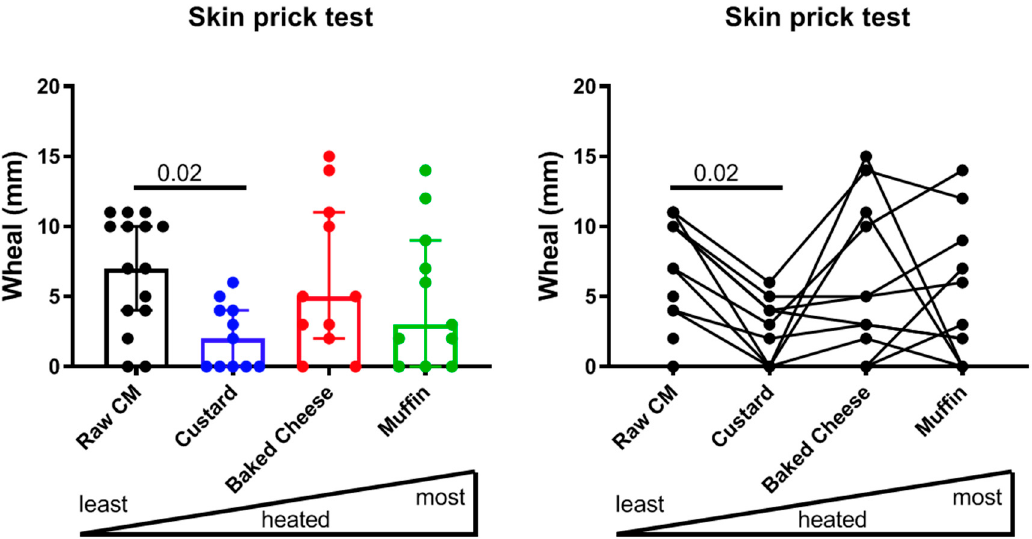
Figure 1. Skin prick test wheal diameters of CM-allergic subjects in response to CM (n = 15), custard (n = 11), baked cheese (n = 11) and muffin extracts (n = 11). The left panel shows a bar graph, with bars indicating median with interquartile range. The right panel shows a line graph with each individual represented by a connected line. Note, four donors tested for raw, pasteurized CM were not tested for the other three extracts. Statistical comparison was performed with the Friedman test (two-tailed), only considering the 11 subjects for whom full data sets were available. p < 0.05 is considered significant.